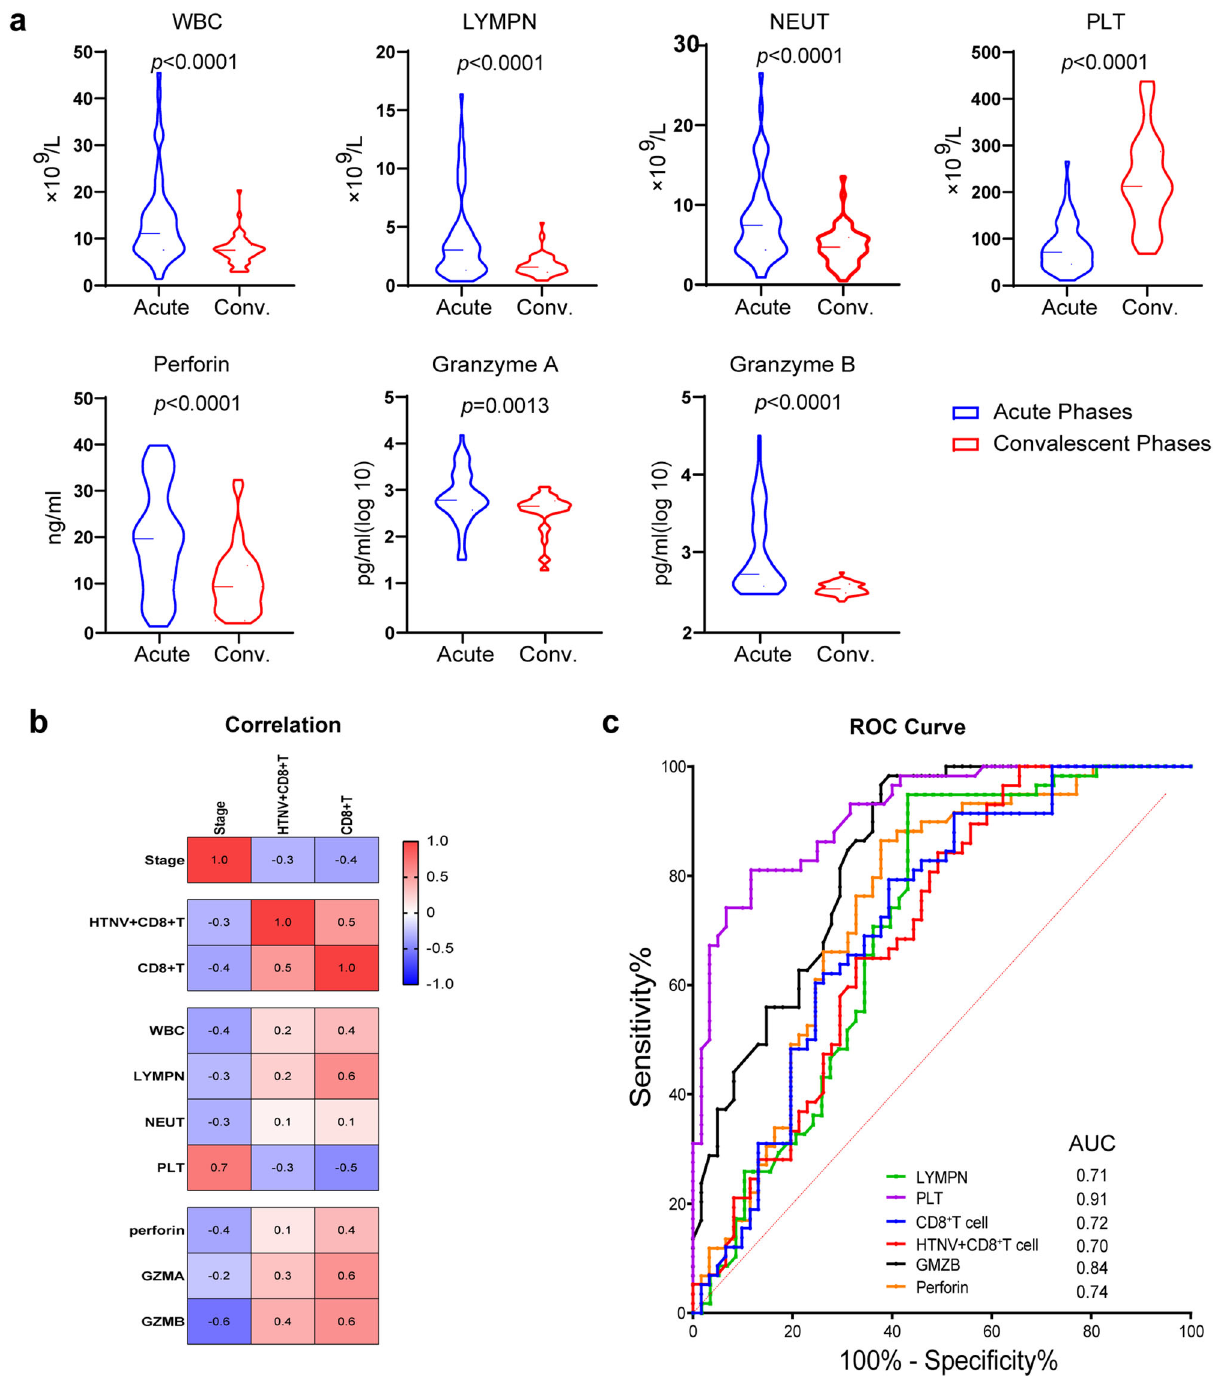
Fig. 4 Correlations between HTNV-infected CD8 + T cells and clinical indices. a Comparisons of white blood cell (WBC), lymphocyte (LYMPH), neutrophil (NEUT), and platelet (PLT) counts and levels of perforin, granzyme A (GZMA), and granzyme B (GZMB) between patients at the acute and convalescent phases of HFRS. Groups were compared using a two-tailed unpaired t -test. (Acute, n = 62; Conv., n = 60). b Correlations between CD8 + T cells or HTNV-infected CD8 + T cells and WBC, LYMPH, NEUT, PLT, perforin, GZMA, and GZMB. Correlations with P < 0.05 are indicated with an r value that ranged from − 1 to 1. Negative correlations are shown in blue and positive correlations in red ( n = 122). c Receiver operating characteristic curve (ROC) and area under the curve (AUC) analyses of the prognostic values of various clinical parameters for HFRS stages. The PLT count had the highest diagnostic value (AUC = 0.9149), followed by secreted GMZB (AUC = 0.8386) and perforin (AUC = 0.7448) levels, the WBC count (AUC = 0.7615) and LYMH count (AUC = 0.7111), and then the percentage of CD8 + T cells (AUC = 0.7195) or HTNV-infected CD8 + T cells (AUC = 0.7). (Acute, n = 62; Conv., n =